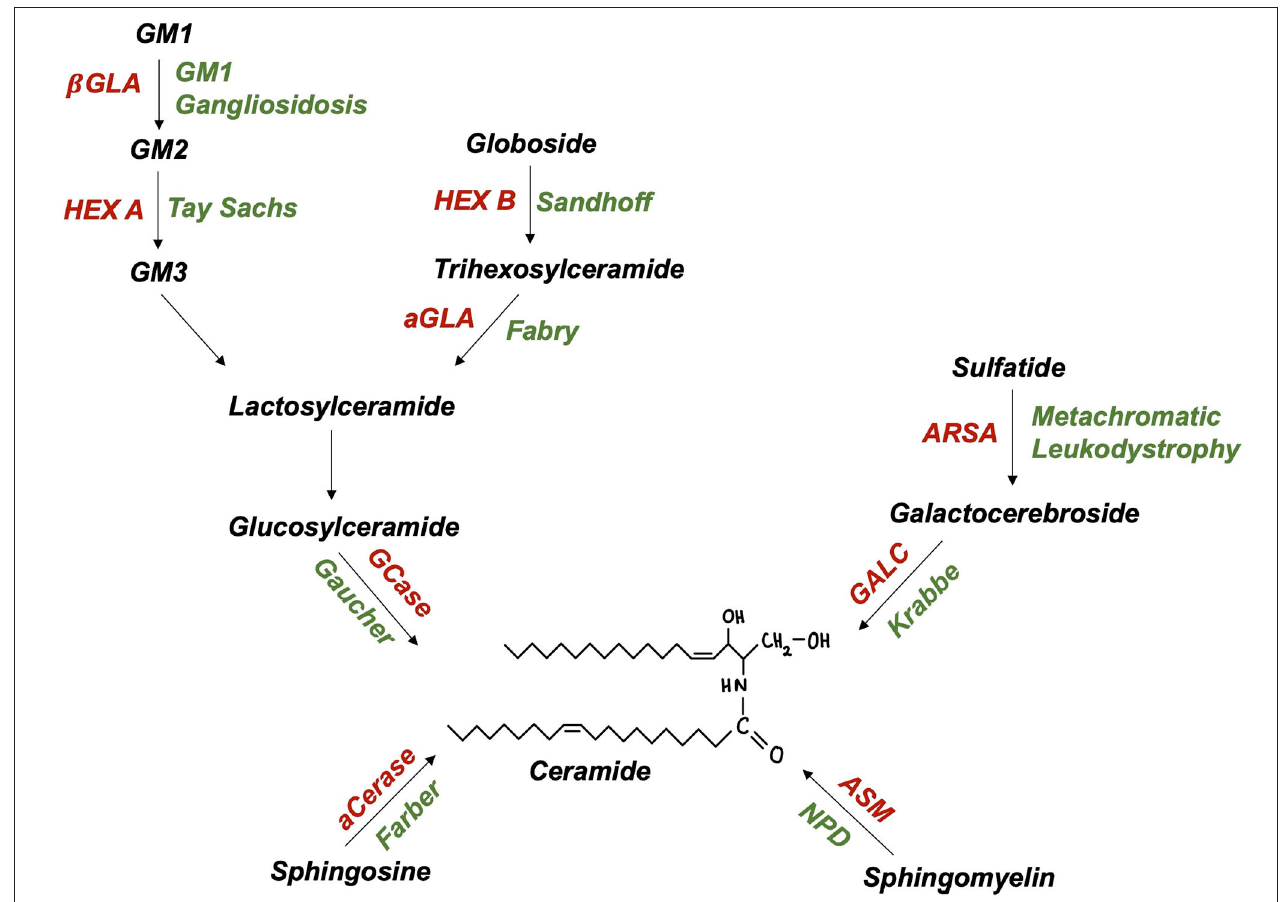
FIGURE 2 | Ceramide and glycolipid metabolism in lysosomes (enzymes in red, autosomal recessive disease in green): aCerase, acid ceramidase; ASM, acid sphingomyelinase; ARSA, arylsulfatase; GALC, galactocerebrosidase; GCase, glucocerebrosidase; aGLA, a-galactosidase; β GLA, β -galactosidase; HEX A/B, hexosaminidase A/B; NPD, Niemann-Pick